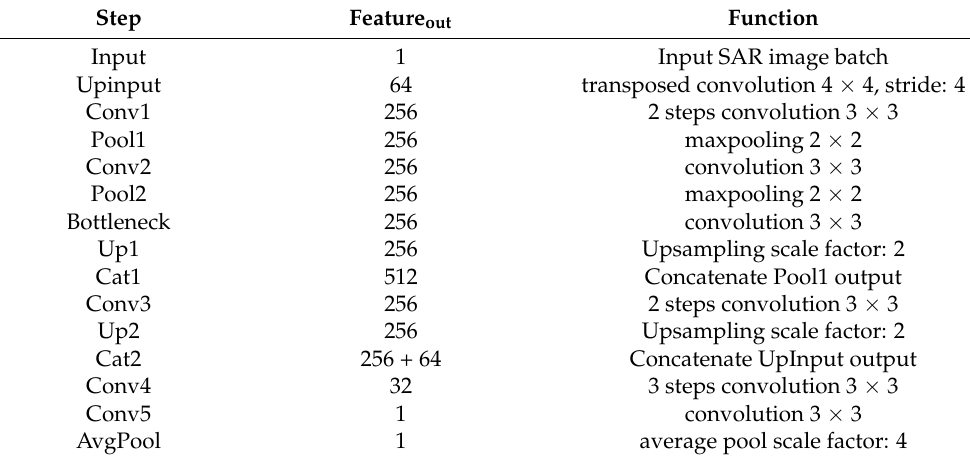
Table 1. Parameters of the denoising deep